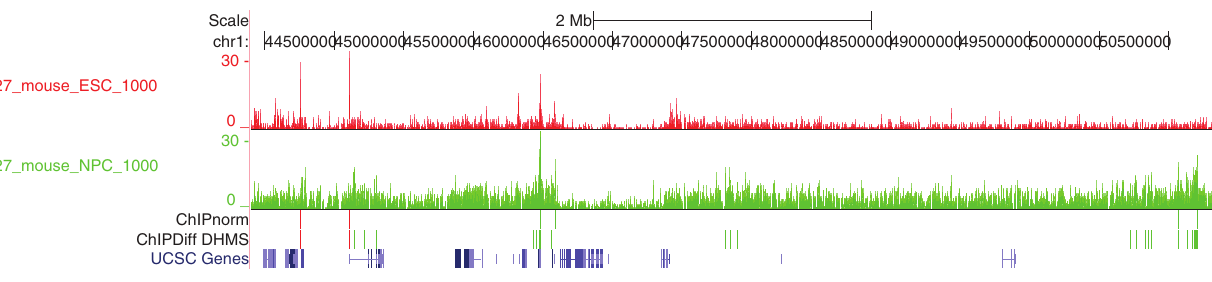
Figure 1. Histone modification profile as seen in the UCSC genome browser [ 17 ] . Tracks 1 (red) and 2 (green) show the H3K27me3 modifications for ES and NP cells, respectively. Track 3 shows the differentially enriched regions found by our ChIPnorm method. Track 4 shows the differentially enriched regions found by the ChIPDiff method [9]. In tracks 3 and 4, red indicates differential enrichment in ES cells and green indicates differential enrichment in NP cells. Track 5 shows the UCSC genes.